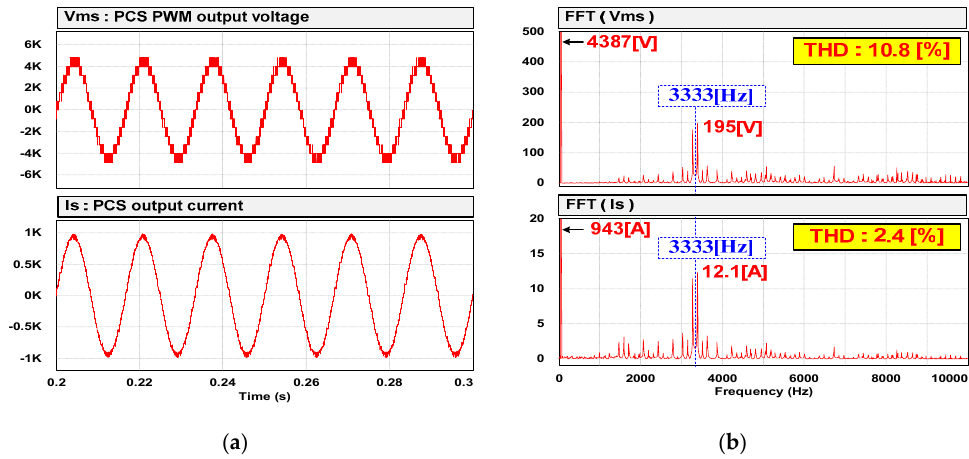
Figure 17. PCS output characteristic analysis simulation results: ( a ) PCS output voltage and current waveforms and ( b ) FFT analyses.